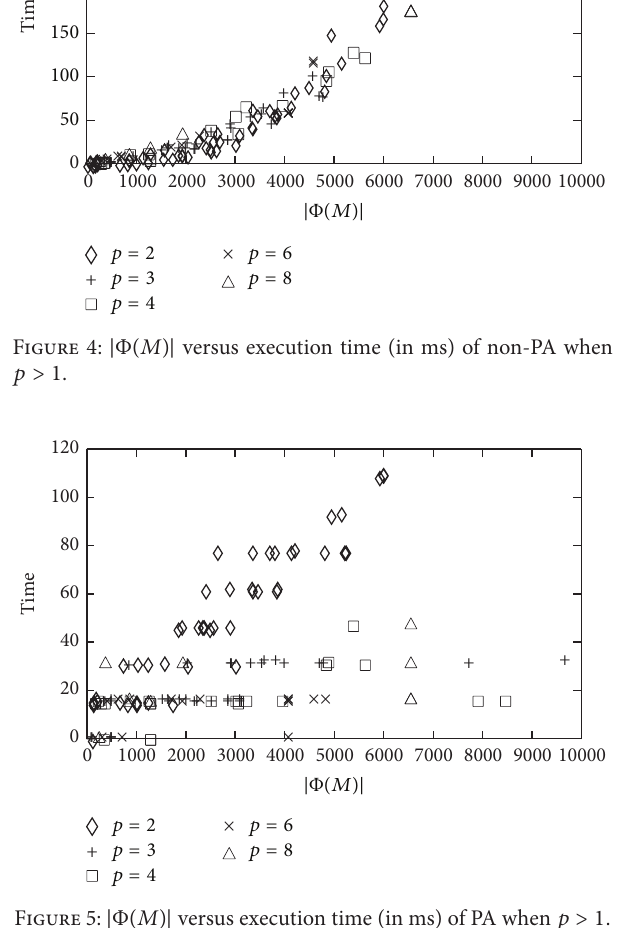
Figure 5: |Φ(𝑀)| versus execution time (in ms) of PA when 𝑝 > 1